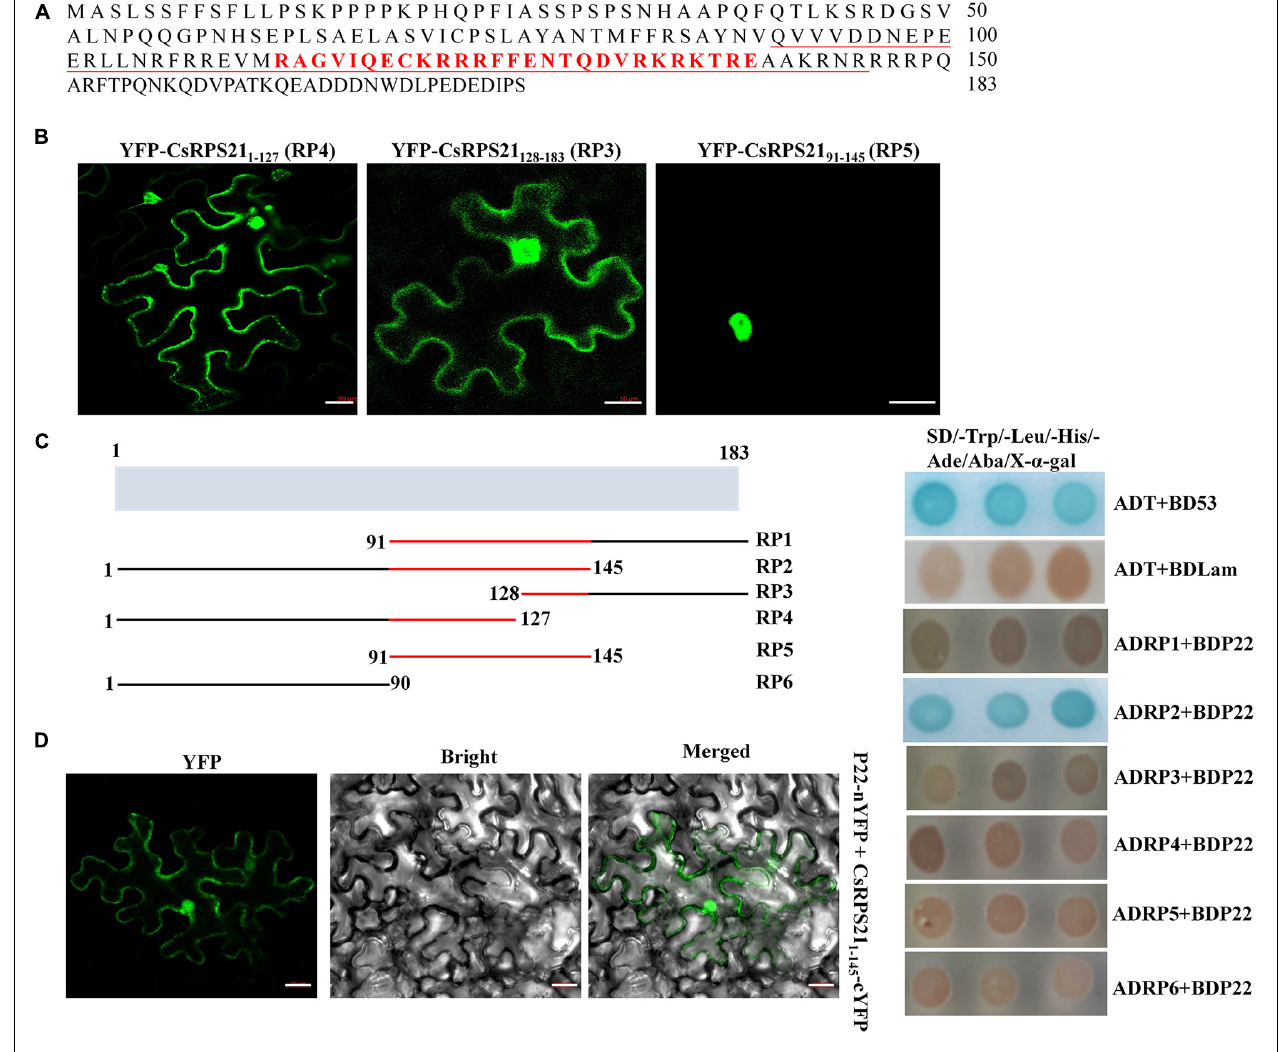
FIGURE 3 | Nuclear localization signal determination and its involvement in the interaction. (A) The full amino acid sequence of CsRPS21. Amino acids constituting the nuclear localization signal predicted using cNLS mapper are shown in red. The conserved ribosomal protein S21 domain predicted using the SMART protein prediction tool is underlined. (B) Three YFP-tagged deletion mutants of CsRPS21 (YFP-CsRPS21 1 − 127 , YFP-CsRPS21 128 − 183 , and YFP-CsRPS21 91 − 145 ) were transiently expressed in N . benthamiana leaves. Bar represents 20 µ m. Photos were taken at 2 dpi using a Zeiss LSM710 laser scanning microscope. (C) Left panel: schematic representation of the CsRPS21 deletion mutants. Six CsPRS21 deletion mutants were used: RP1 (residues 91–183), RP2 (residues 1–145), RP3 (residues 128–183), RP4 (residues 1–127), RP5 (residues 91–145), and RP6 (residues 1–90). Right panel: Interaction between BDP22 and the CsRPS21 deletion mutants. Growth of Y2HGold yeast cells co-transformed with BDP22 and ADRP1, ADRP2, ADRP3, ADRP4, ADRP5, or ADRP6 on high-stringency selection medium (SD/–Leu/–Trp/–His/–Ade/Aba/X- α -gal). (D) Interaction between P22 and CsRPS21 1 − 145 (RP2) in N . benthamiana epidermal cells using BiFC. P22 fused with the N-terminal portion of YFP (P22-nYFP) was transiently co-expressed with CsRPS21 1 − 145 fused with the C-terminal portion of YFP (CsRPS21 1 − 145 -cYFP). Bar represents 20 µ m. Photos were taken at 3 dpi using a Zeiss LSM710 laser scanning